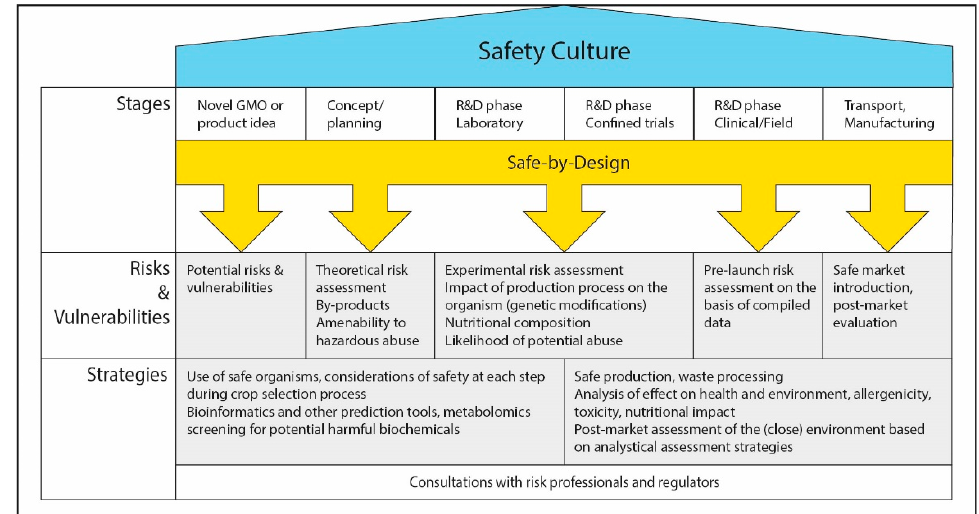
Figure 1. Safe-by-design concept in crop breeding: workflow from conceptualization of an idea until the release of the product on the market. Safe-by-design is an approach wherein safety evaluation is an inherent part of every stage of development, which may lead to the initiation of strategies to mitigate risks and vulnerabilities, and may ultimately contribute to the establishment of a safety culture.